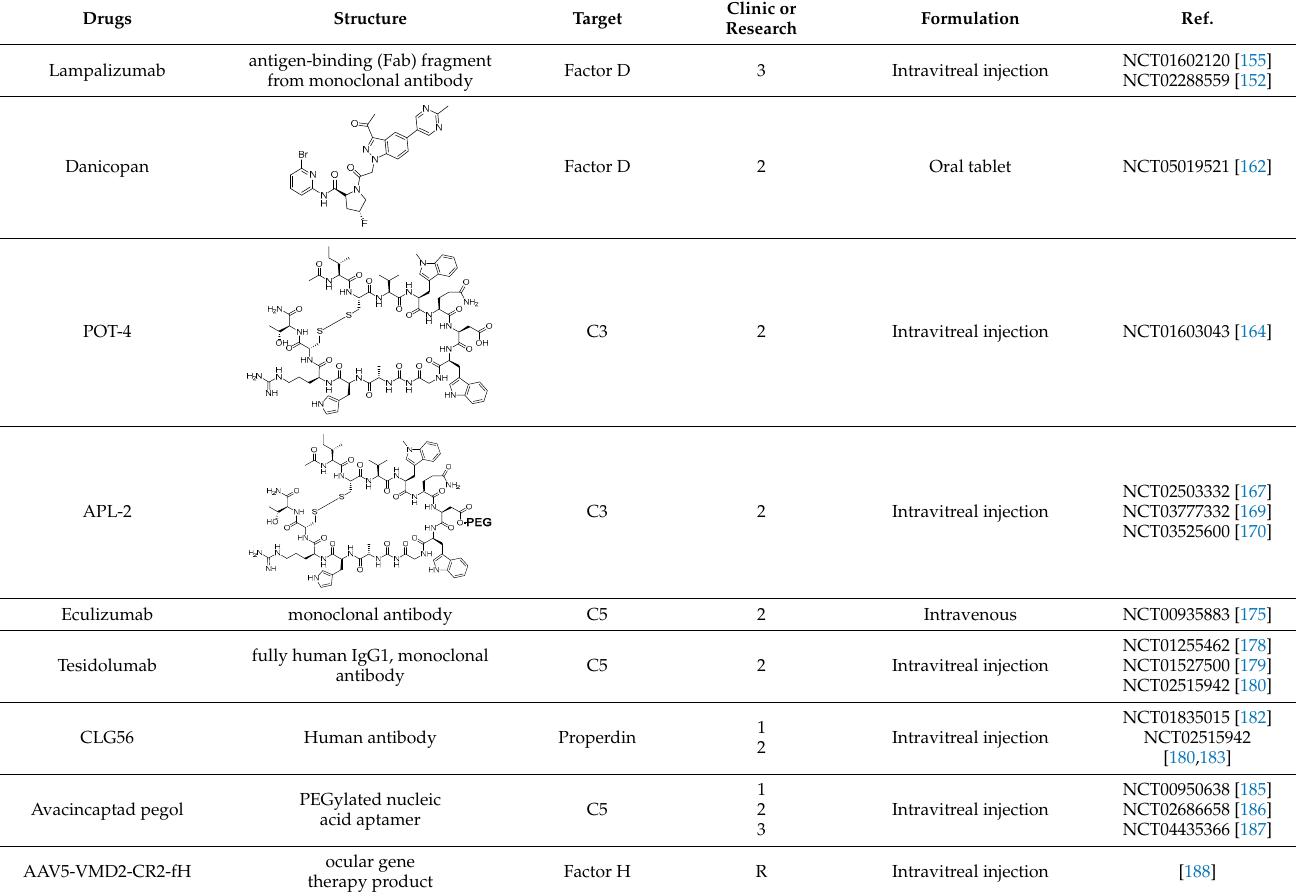
Table 7. Drugs targeting inflammation.